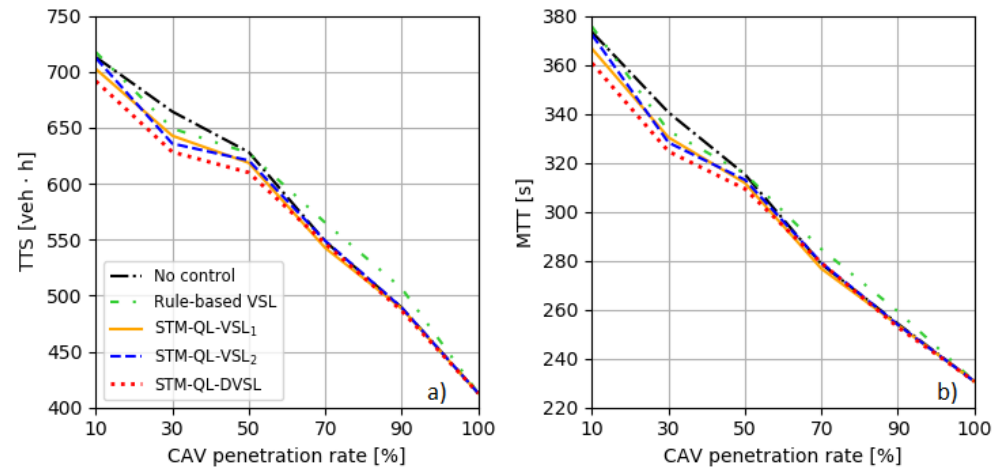
Figure 6. Change of TTT ( a ) and MTT ( b ) for different CAV penetration